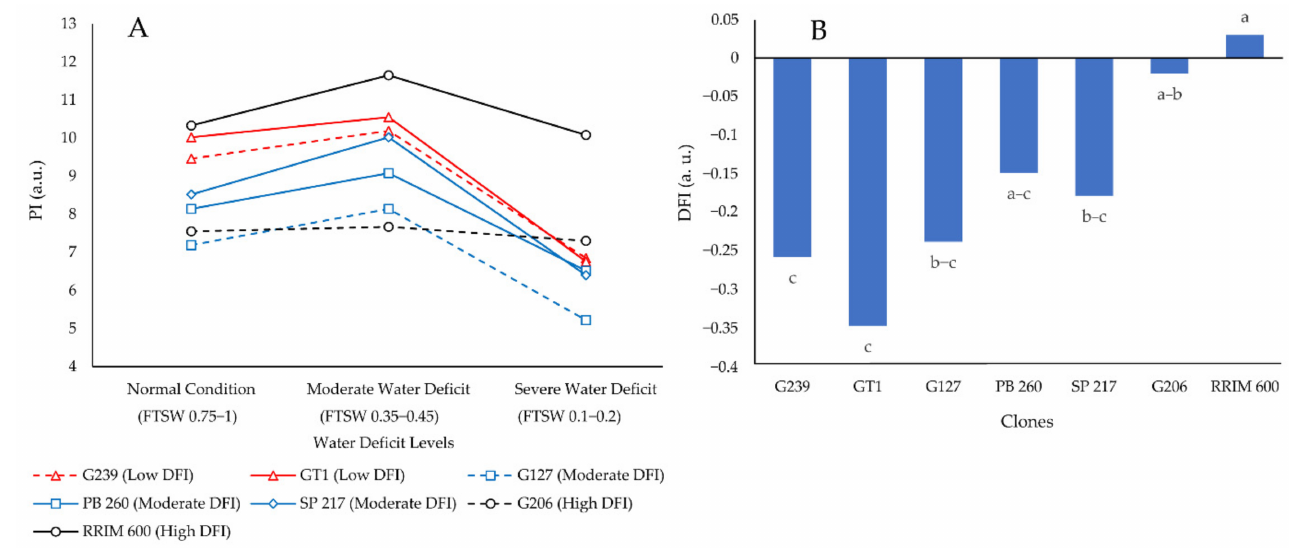
Figure 1. Fluctuations in PI ( A ) and DFI ( B ) of seven different rubber clones under normal, moderate, and severe water deficit conditions. a.u. stands for arbitrary unit. The different letters represent significantly different means as determined by the Least Significant Difference test at 95% confidence.